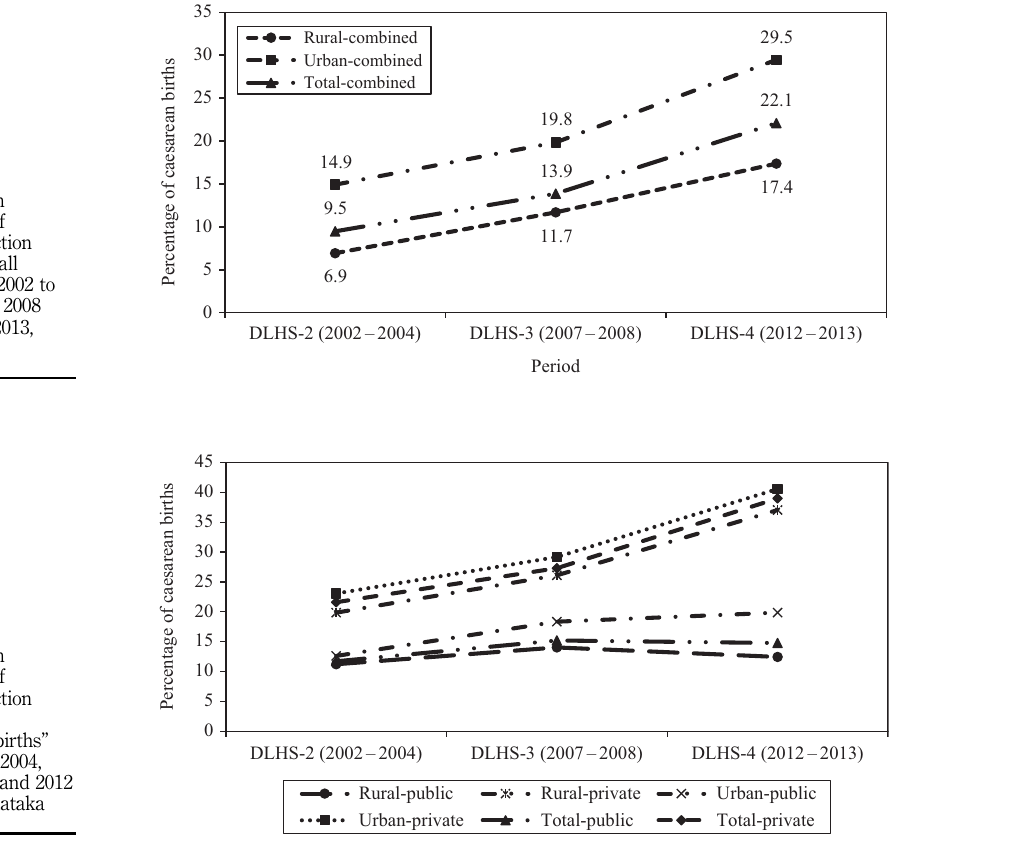
Figure 1. Prevalence (in percentage) of caesarean section